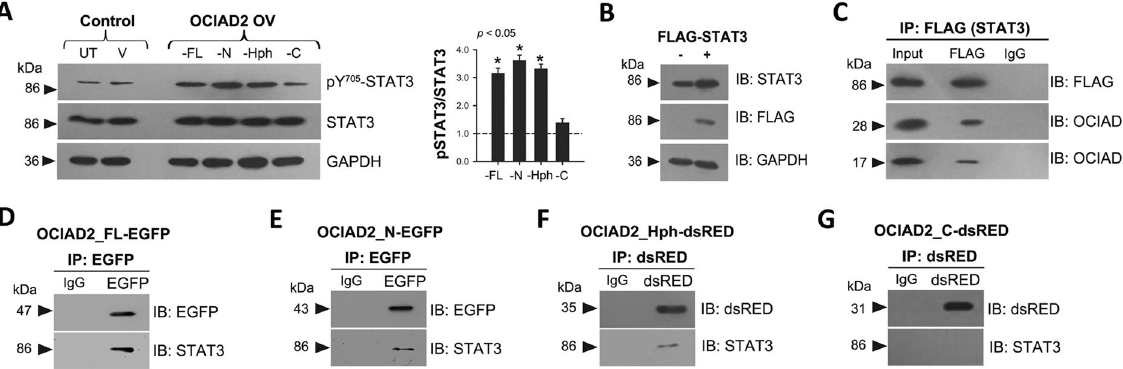
Figure 6. The double helical motif of OCIAD2 interacts with STAT3 and promotes its activation. ( A ) Western Blotting for detection of STAT3 and pSTAT3 (Y705) levels in HEK293 cells transfected with various OCIAD2 constructs as indicated. UT: untransfected, V: empty vector transfected; FL: OCIAD2_FL-EGFP; N: OCIAD2_N- EGFP; Hph: OCIAD2_Hph-dsRed and C: OCIAD2_C-dsRed. Graph represents pSTAT3/STAT3 ratio obtained upon overexpression of various OCIAD2 constructs relative to control (shown as a dotted line). n = 4 ( B ) Validation of transfection of FLAG-STAT3 construct into HEK293 cells by Western Blotting. ( C ) FLAG-STAT3 transfected HEK293 cell lysate subjected to immunoprecipitation with anti-FLAG antibody and assessed for interaction with OCIAD1 and OCIAD2. ( D – G ) HEK293 cell lysates expressing various OCIAD2 constructs (FL, N, Hph and C) were subjected to immunoprecipitation (IP) followed by immunoblotting (IB) to probe for interaction with STAT3. Protein size markers (in kDa) are indicated to the left. Data for STAT3/pSTAT3 Western Blotting are representative of three independent experiments and * p < 0.05 was used to indicate a statistically significant difference. At least two independent experiments with two technical replicates each were performed and similar results were obtained. Full-length blots are presented in Supplementary Figure